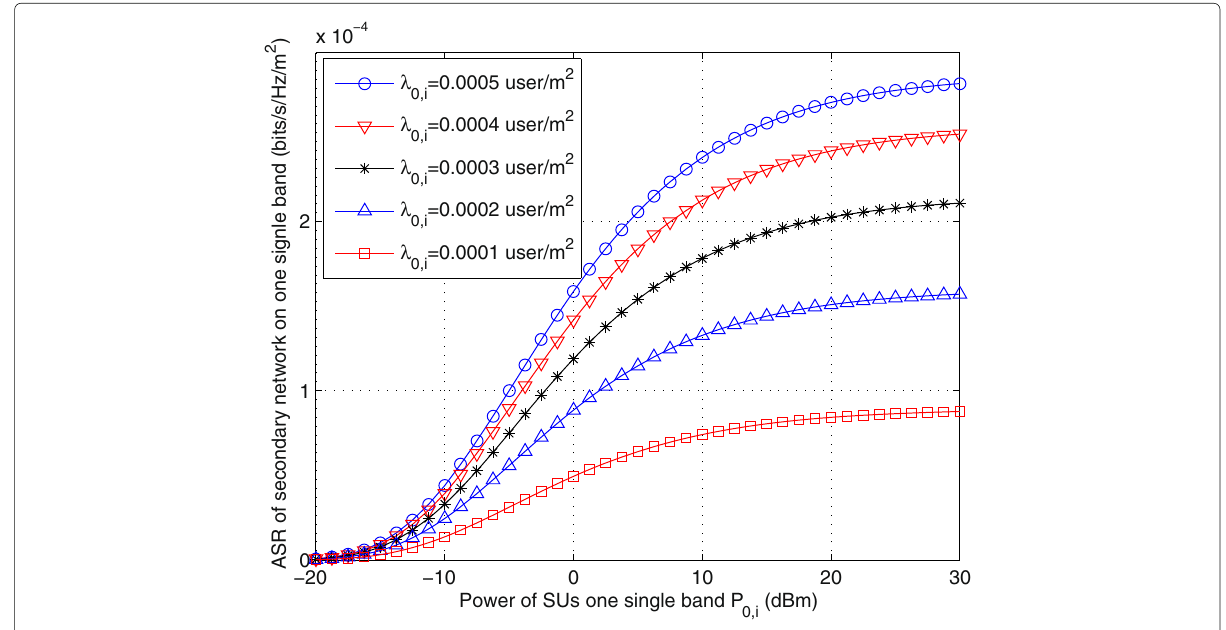
Fig. 6 ASR of the secondary network vs. power of SUs on one single band